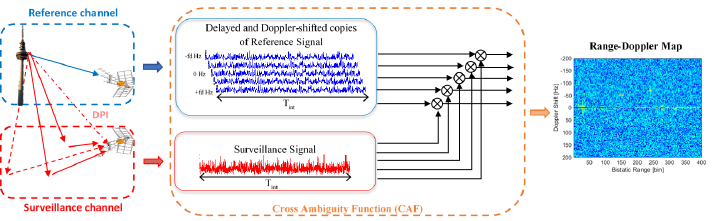
Figure 1. PR geometry scheme and operation principle. Reference signal (blue), surveillance signal components (red): targets’ echoes (continuous), sea clutter (dashed) and Direct Path Interference or DPI (dash and dotted).